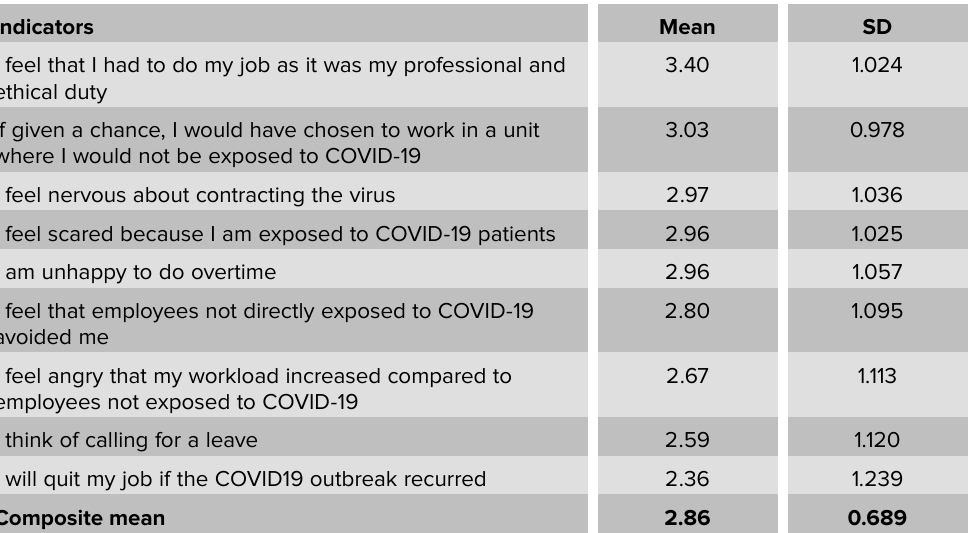
TABLE 1: Nurses’ feelings during COVID-19